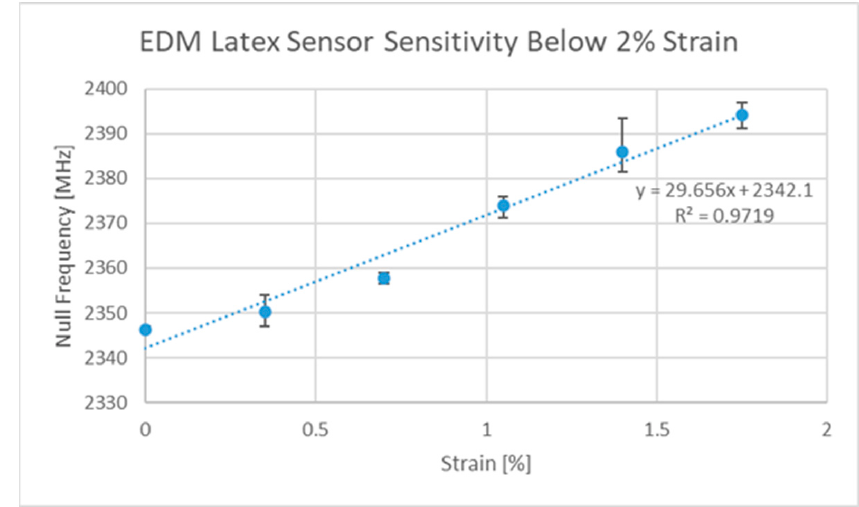
10 of 24 Figure 7. V3 axial strain sensitivity curve. Figure 8. V3 transverse strain sensitivity curve. The V1 design was originally published in [6] and a new version of the design is characterized in Figures 9 and 10, which includes a since ‐ unreported transverse strain sensitivity result. This new implementation was made in the same way as the previous publication except the adhesion between the resonator and the latex substrate was en ‐ hanced and was not emphasized at the centroids of the resonator parts. The result of this was a design with a slightly lower axial sensitivity of 29.7 MHz/% ε as opposed to 32.9 MHz/% ε but said changes in the adhesion resulted in a significant decrease in the trans ‐